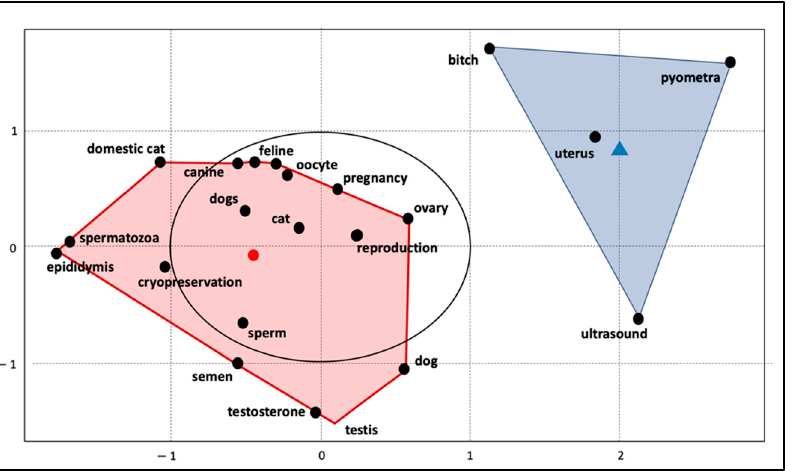
Figure 5. Clustering map (multifactorial analysis) of author keywords in the field of small animal reproduction. The main words are grouped in two clusters. The center of the map (black circle) represents the center of the research field.